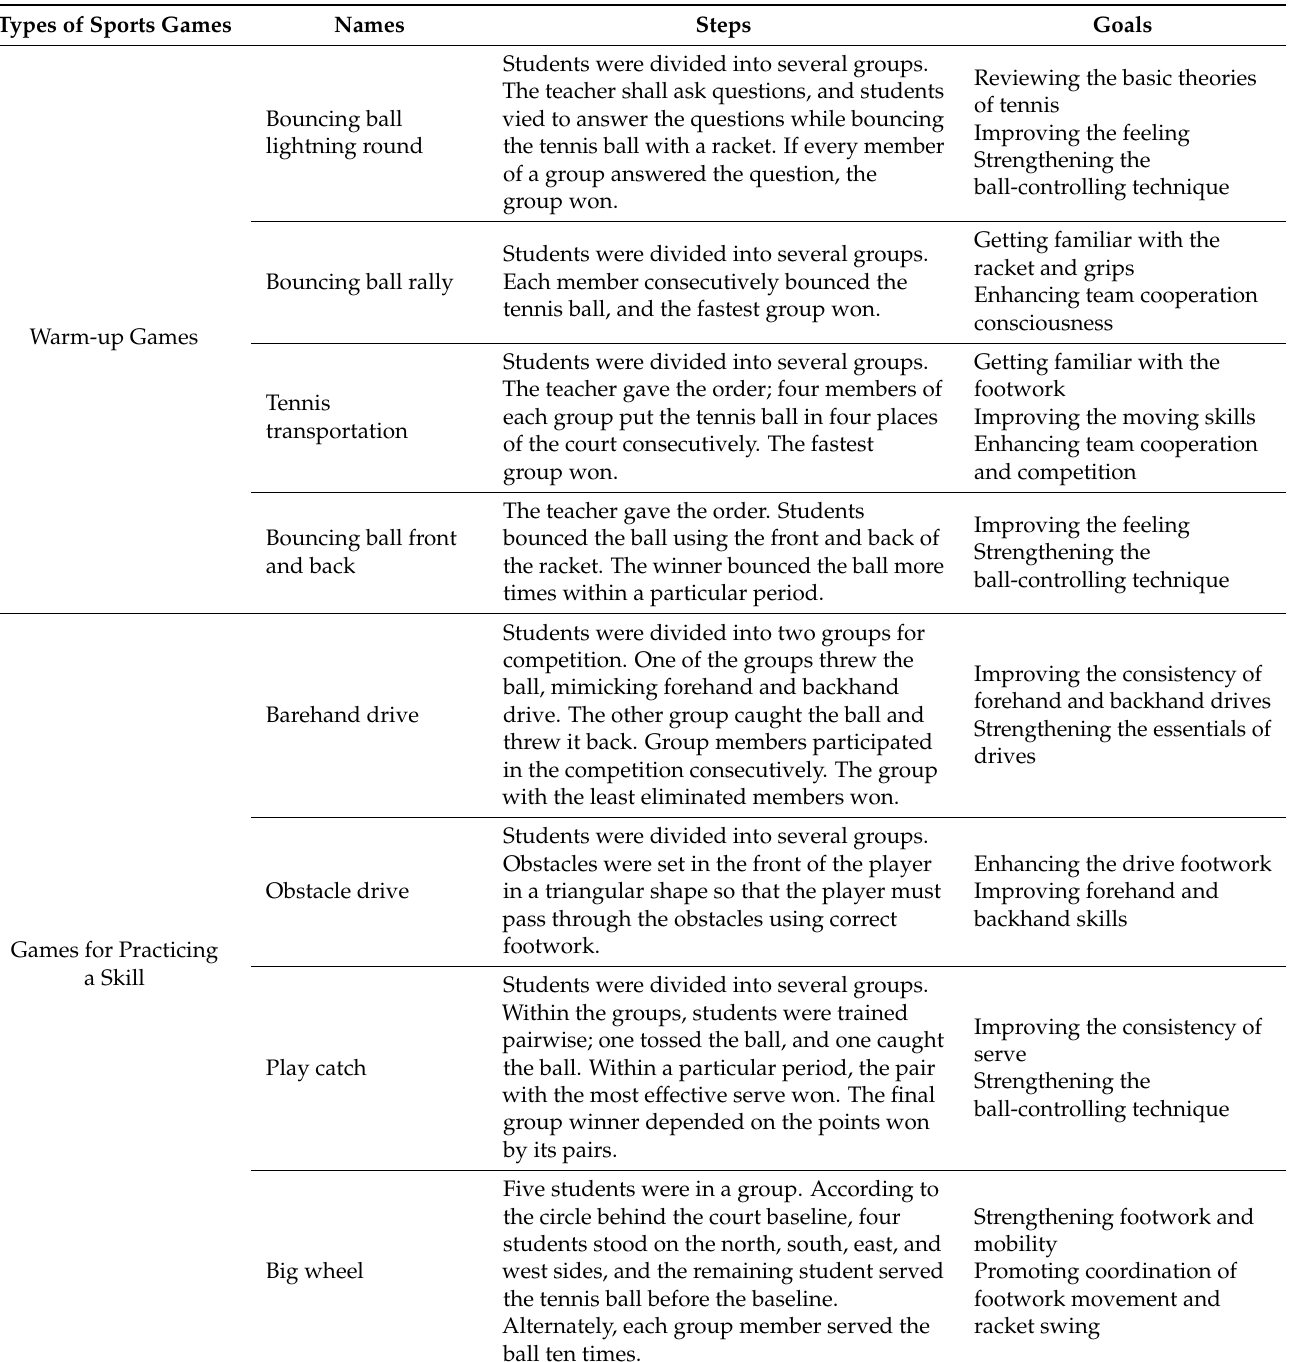
Table 4. Sports Games of Tennis